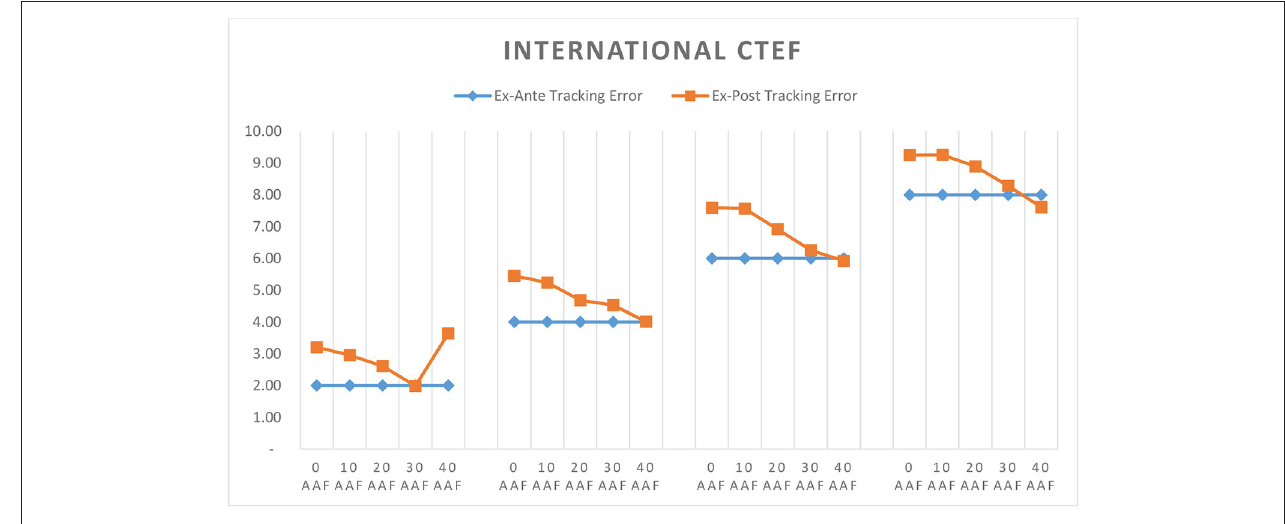
FIGURE 10 | International CTEF ex-ante vs. ex-post tracking error.